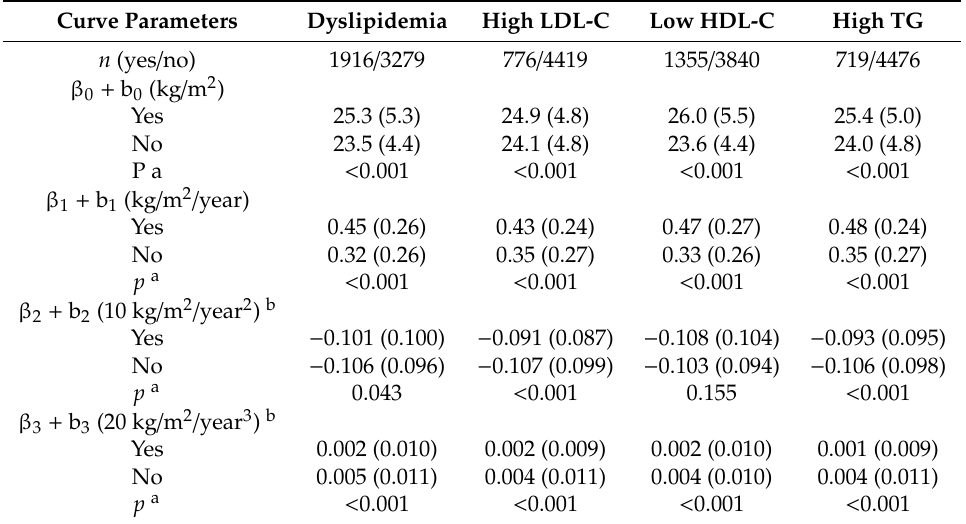
p a < 0.001 < 0.001 < 0.001 <